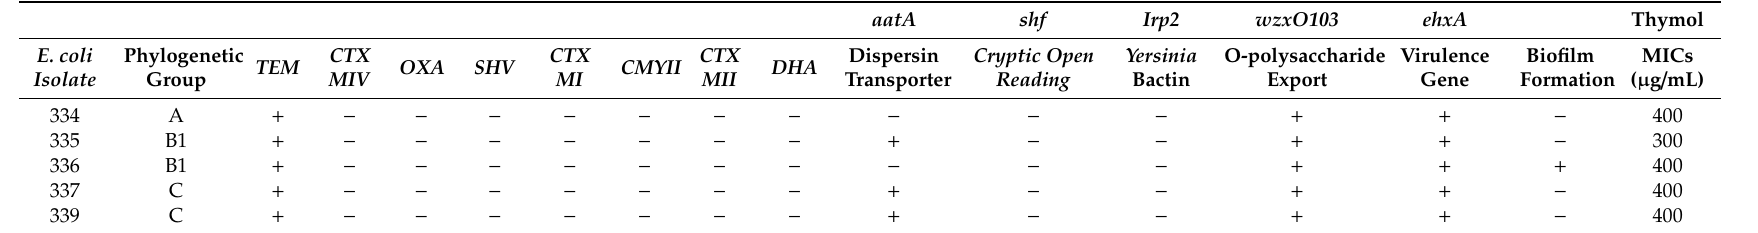
Table 1. Genetic analysis on Escherichia coli isolates, biofilm formation, and thymol MIC